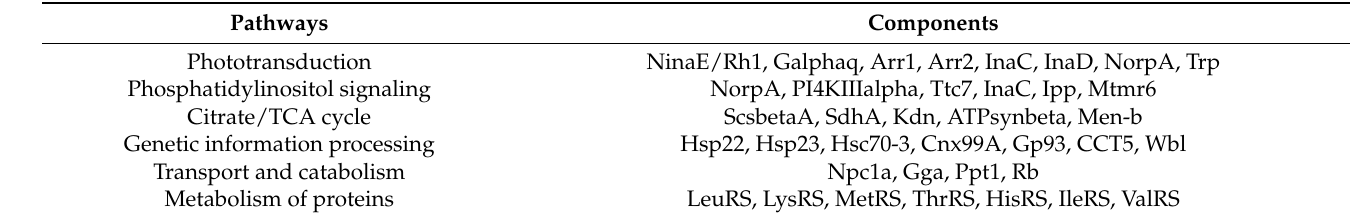
Table 1. Pathways and their protein components that respond to vitamin A deficiency in the Drosophila eye. For details, see text. Pathways